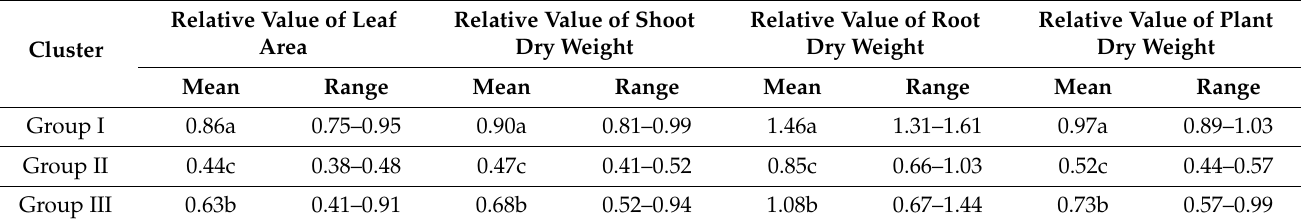
Table 2. The low-nitrogen tolerance of each cluster